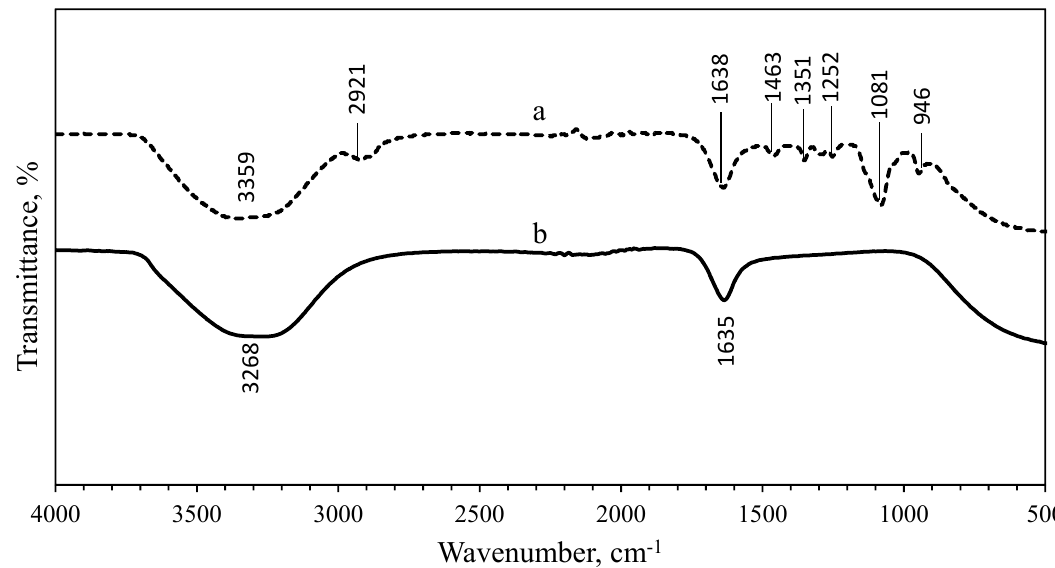
Figure 5. Comparison of FTIR spectrum between PEG-coated ( a ) and uncoated ( b ) chemically synthesised AgNPs.